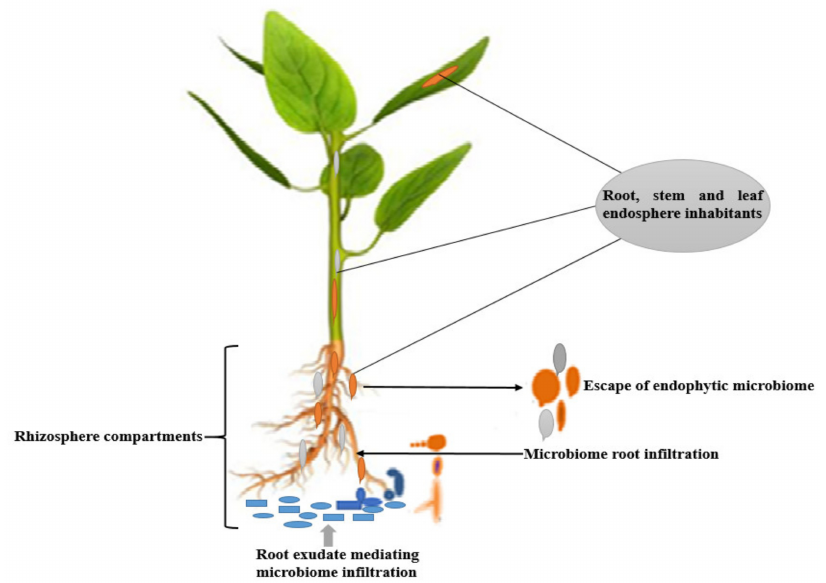
Figure 1. Plant roots showing root exudates attracting plant growth-promoting bacteria into the root tissues as endophytes and also expelling bacteria from the root tissues into the rhizosphere